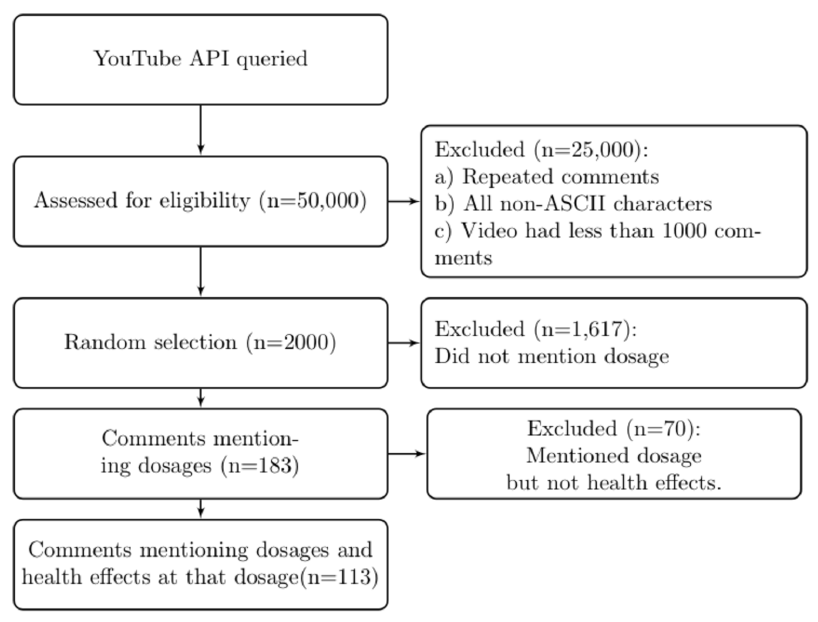
Figure 7. Extraction of YouTube Comments for Analysis.